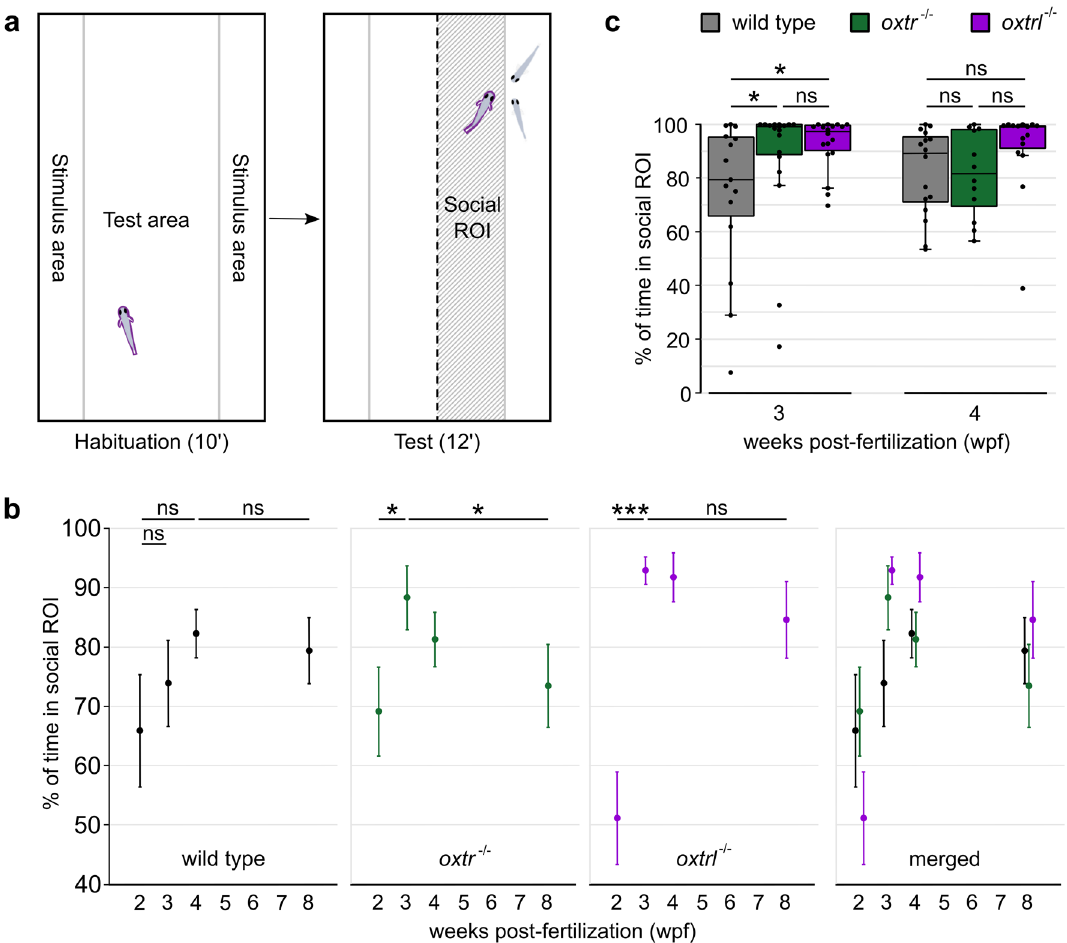
Figure 1. Oxytocin receptors affect the development, intensity and maintenance of social preference. ( a ) The behavioral chamber for social preference tests was composed of one test area and two stimulus areas, divided by transparent walls. After a habituation period, two stimulus fish were added to one stimulus area and the half next to the stimulus fish was defined as “social ROI” during analysis. ( b ) Social preference developed faster in both the oxtr −/− and oxtrl −/− fish and in oxtr −/− fish the maintenance of social preference was impaired. Values are reported as mean ± standard error of the mean (s.e.m.). Asterisks represent the statistical comparison of age in the different genotypes. n(social wildtype, 2 wpf) = 15, n(social wildtype, 3 wpf) = 15, n(social